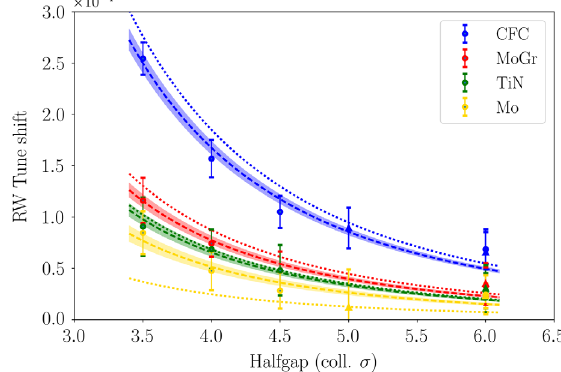
FIG. 5. The use of uncoated MoGr (red) reduces the resistive wall tune shift compared to the uncoated CFC (blue); each type of coating: TiN (green) and Mo (yellow) further improves the conductivity and can be clearly differentiated. For most materials the results are within 10 – 20% of the model predictions (dotted lines). Dots and triangles show the measured data obtained for the nominal intensity of 1 . 2 × 10 11 p and the high intensity of 1 . 9 × 10 11 p (scaled down to the nominal intensity) respectively. The dashed curves represent Eq. (1) fits with their (cid:3) 1 rms uncertainties.